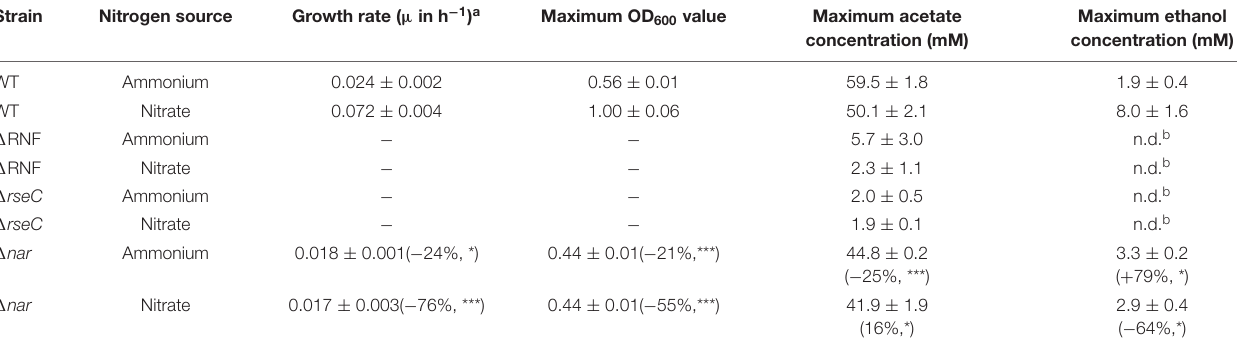
TABLE 1 | Performance of all tested C. ljungdahlii strains in autotrophic batch cultivation experiments. Strain Nitrogen